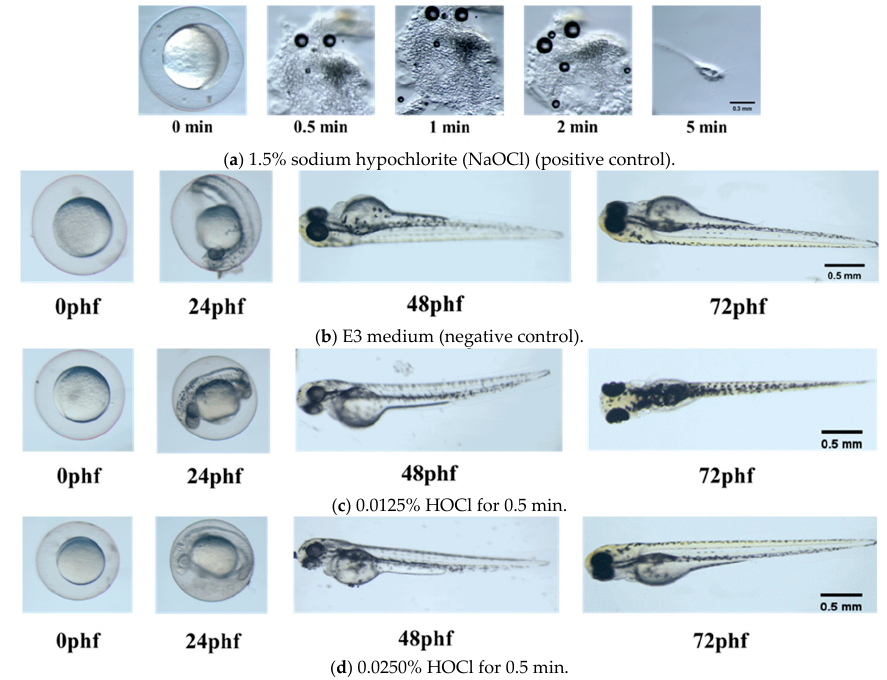
Figure 1. Photomicrograph of Zebrafish embryo. ( a ) Zebrafish embryo in 1.5% NaOCl (positive control). ( b ) Zebrafish embryo in E3 medium (negative control). ( c ) Zebrafish embryo in 0.0125% HOCl for 0.5 min. ( d ) Zebrafish embryo in 0.0250% HOCl for 0.5